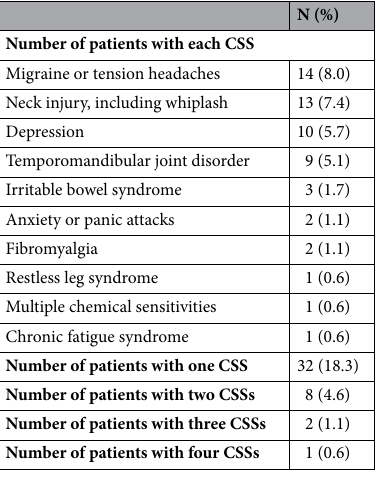
Table 1. Central sensitivity syndrome prevalence in patients with hip osteoarthritis (N = 175). CSS central sensitivity